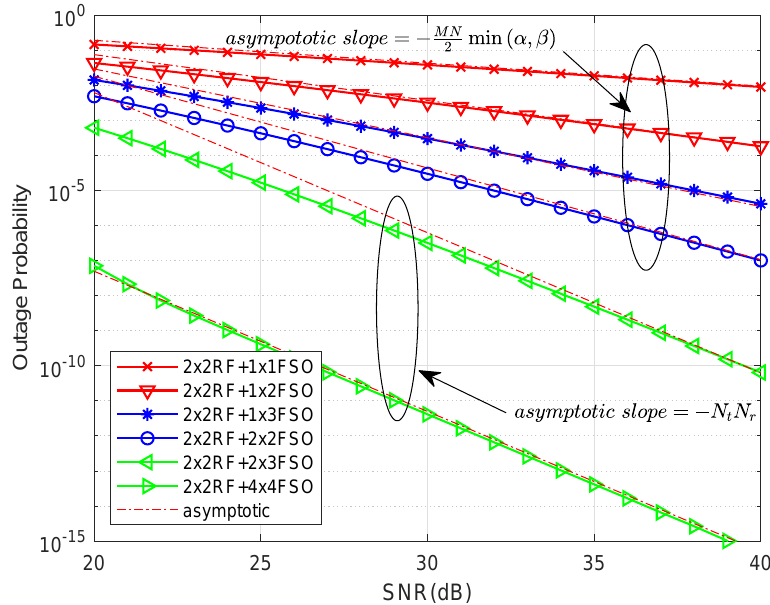
Figure 4. Outage probability of different scheme MIMO mixed RF/FSO system.